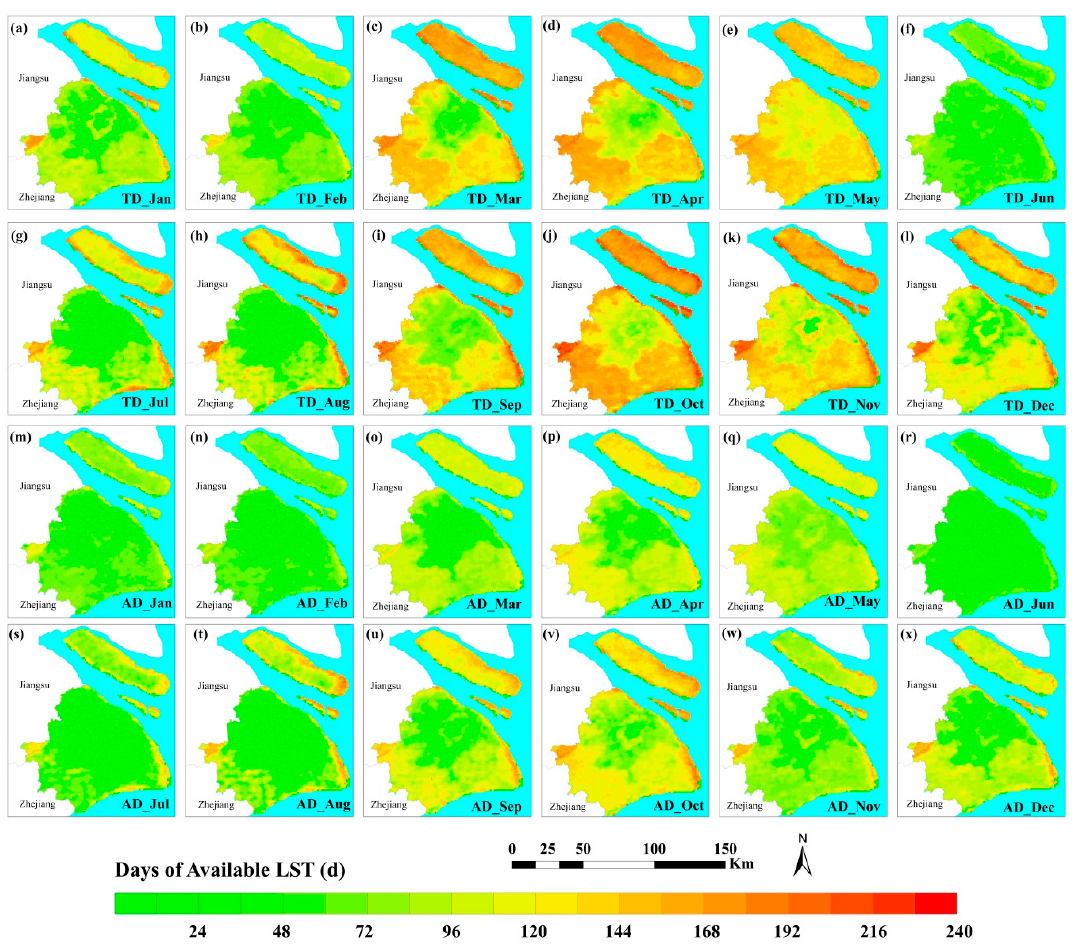
Figure 2. The amount of available daytime LST per month for MODIS Terra 2000–2013 and Aqua 2002–2013, respectively: ( a – l ) each month at the Terra daytime (TD) overpass; and ( m – x ) each month at the Aqua daytime (AD) overpass.